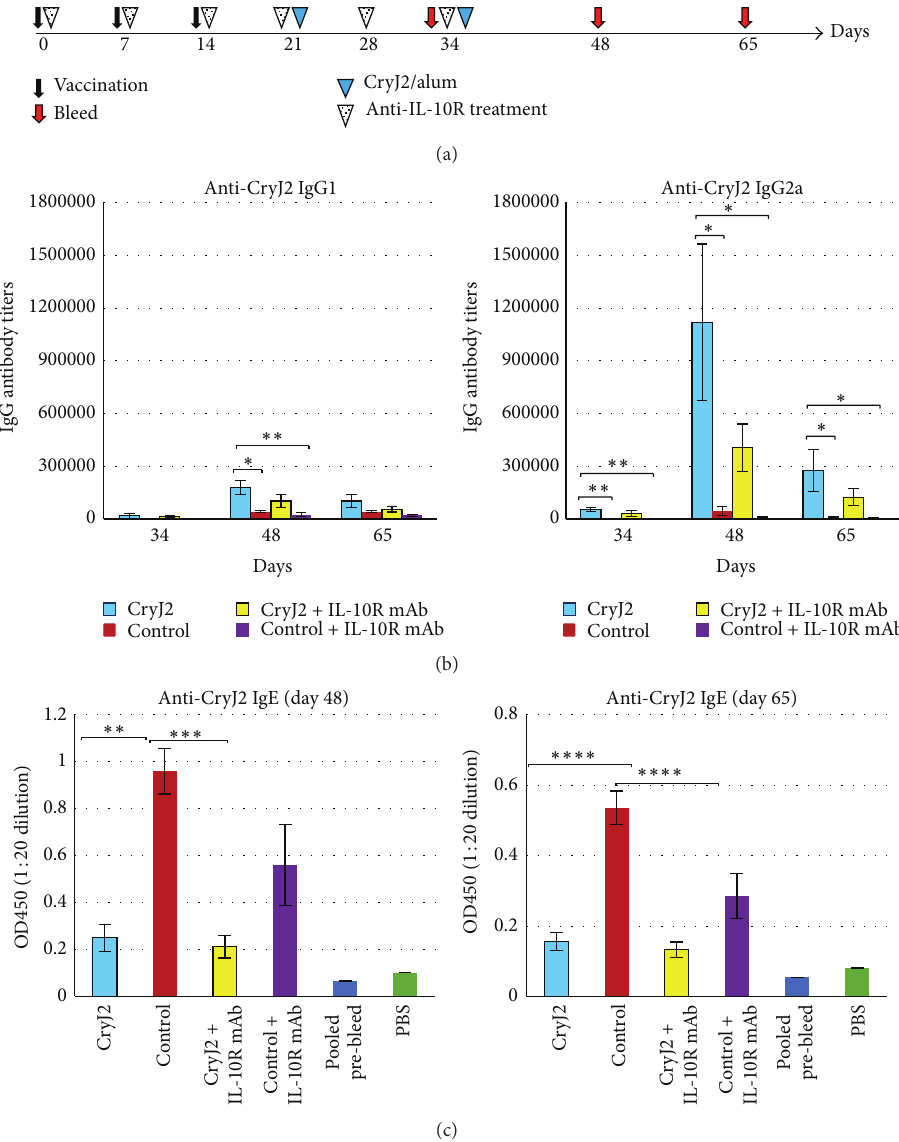
Figure 7: IL-10R blockage does not change the priming of Th1 responses upon DNA vaccination. (a) Schematic view of vaccination protocol. Four groups of mice ( 𝑛 = 5 ) were immunized with 50 𝜇 g control vector or 50 𝜇 g CryJ2-LAMP. Two groups were treated weekly with 0.5 mg anti-IL-10R mAb (clone 1B1.3a) six times by i.p. injection. Then recipients were boosted with 5 𝜇 g CryJ2 and bled as indicated. (b) Anti-CryJ2 IgG1 and IgG2a antibodies were analyzed by ELISA. (c) Anti-CryJ2 IgE antibodies were determined by ELISA and depicted are results of OD 450 values at a serum dilution of 1: 20. All data are shown as mean ± SEM. ∗ 𝑝 < 0.05 , ∗∗ 𝑝 < 0.01 , ∗∗∗ 𝑝 < 0.001 , and ∗∗∗∗ 𝑝 < 0.0001